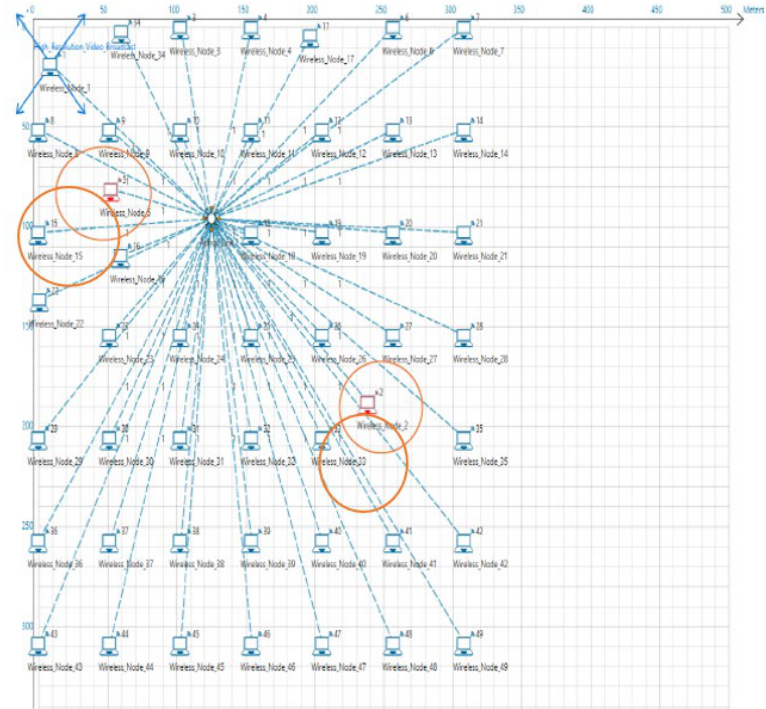
Figure 13. Network model of 49 nodes with two sinkhole nodes added.